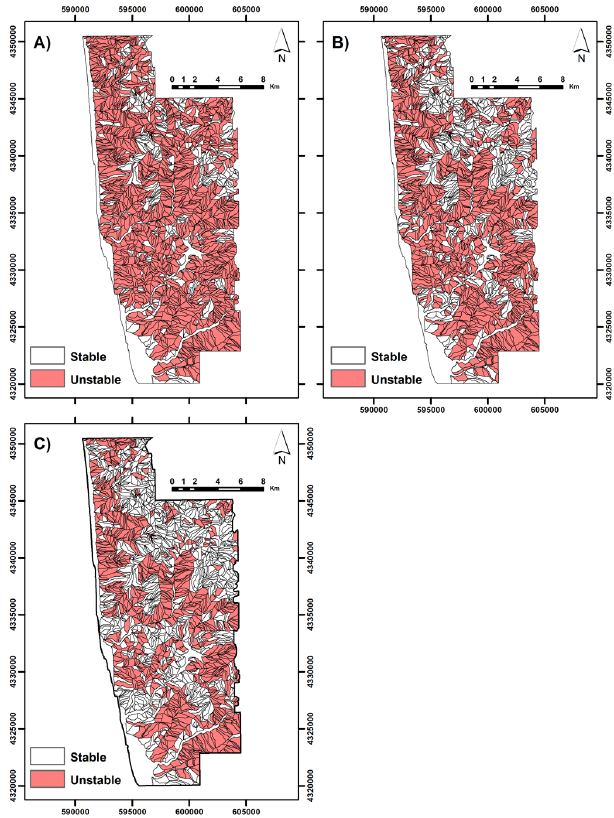
Fig. 9. Stable and unstable slope unit maps related to tested land- slide frequency threshold (Lft): (A) Lft > 5%; (B) Lft > 20%; (C) Lft > 40%.